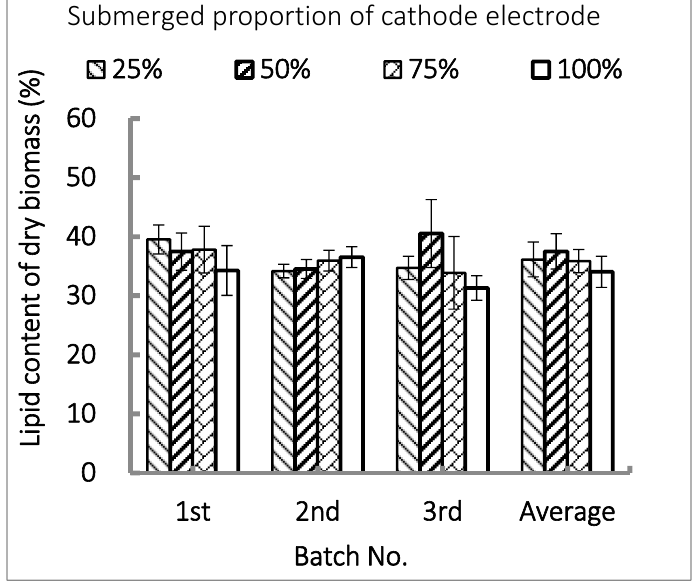
Figure A1. Lipid production of microalgae from wastewater with partially and completely submerged electrodes in the cathode chamber.